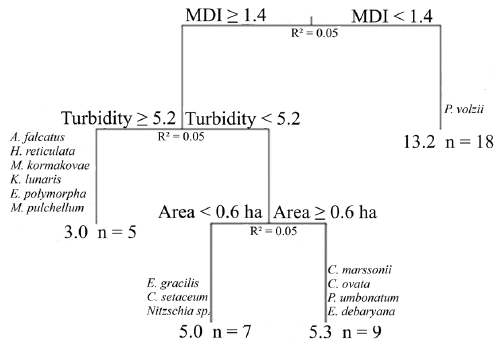
Figure 2. MRT analysis of the interaction between species density and local predictors of the 40 reservoirs sampled during the rainy season (R 2 = 0.15). n is the number of sample units; the number on the left is the sum of the squares of the errors in each group. The species presented in each group are the most important for the explanation of each group. MDI = margin development index. The turbidity unity of measurement is NTU. Error = 0.8, CV Error = 1.2, SE = 0.04. Data used from Silva et al.